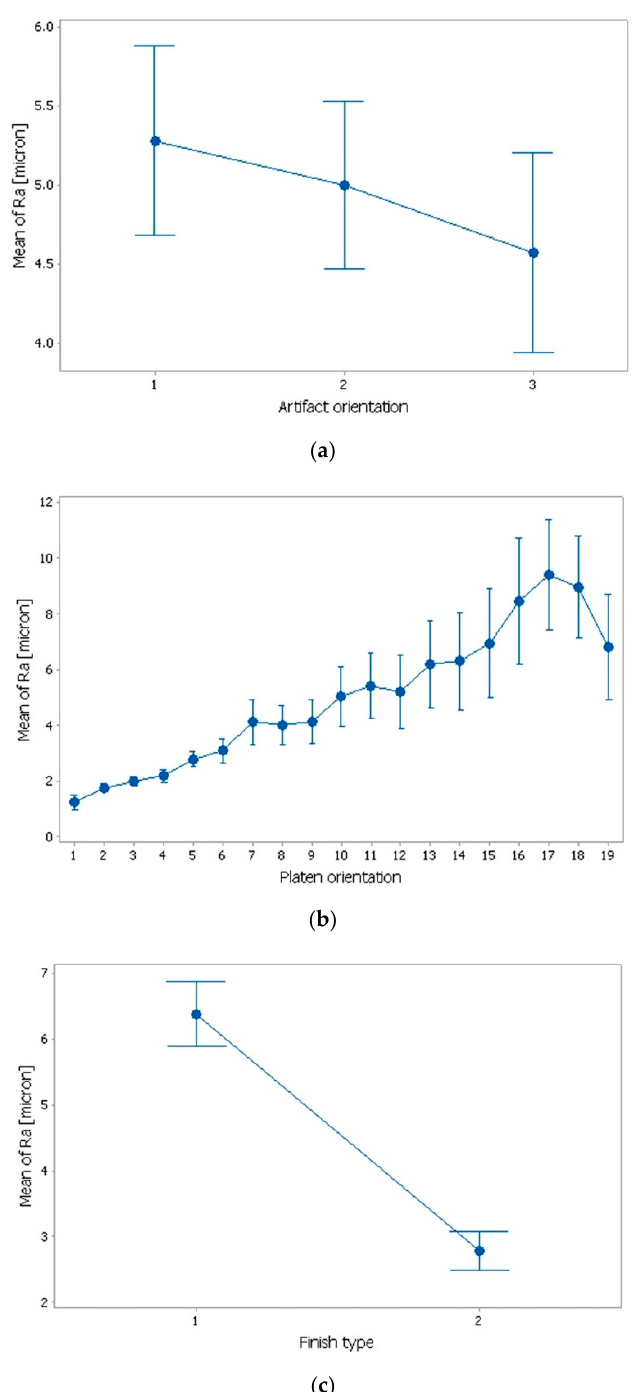
Figure 17. Individual standard deviations were used to calculate the intervals plot of surface roughness (Ra) versus ( a ) artifact orientation, ( b ) platen orientation, and ( c ) finish type. Bars are standard errors of the mean.